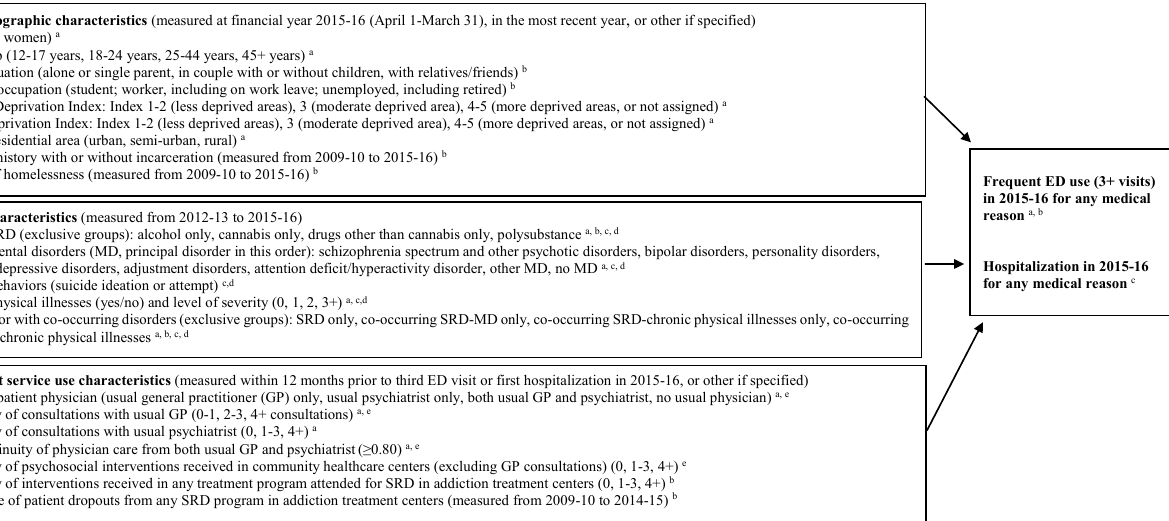
Figure 1. Conceptual framework: predictors of frequent emergency department (ED) use and hospitalization among patients with substance-related disorders (SRD). a Régie de l’assurance maladie du Québec (RAMQ, physician database); b Système d'information clientèle pour les services de réadaptation dépendances (SIC-SRD, addiction treatment center database, including SRD diagnostics based on standardized instruments); c Banque de données communes des urgences (BDCU, ED database); d Maintenance et exploitation des donn é es pour l’ é tude de la client è le hospitali è re (MED-ECHO, hospitalization database); e Syst è me d’information permettant la gestion de l’information clinique et administrative dans le domaine de la sant é et des services sociaux (1-CLSC, psychosocial interventions in community healthcare centers, including GP working on salary). For definitions of variables included in the study see footnotes